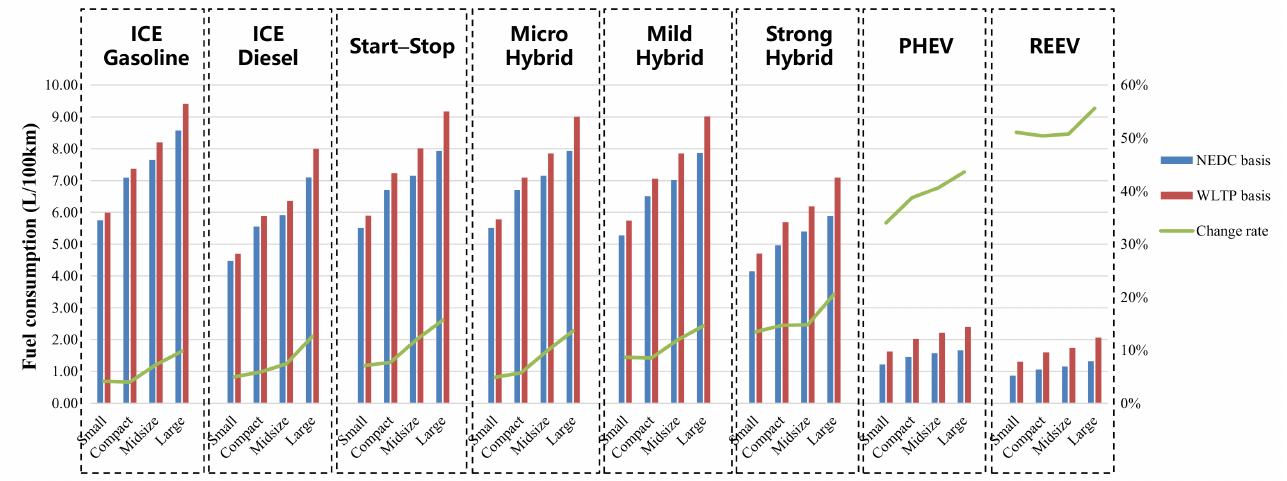
Figure 4. Fuel consumption of the baseline vehicles with different